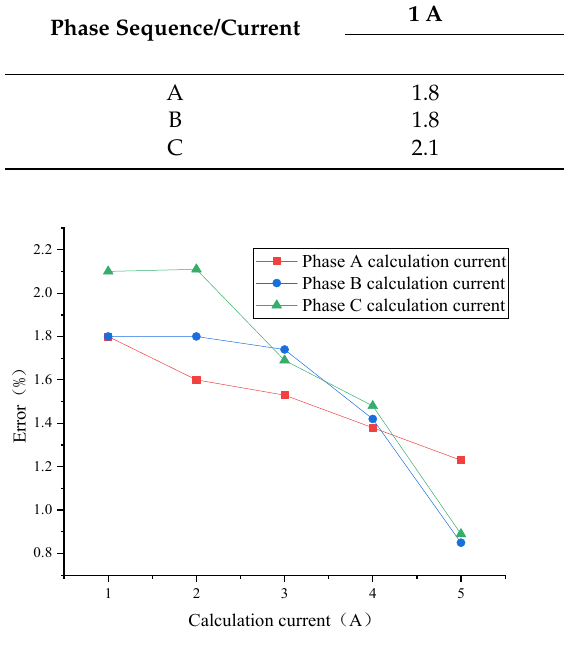
Figure 19. Error curve of the restored current.